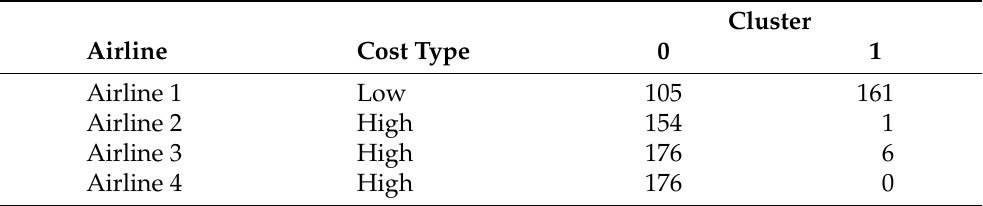
Table 3. Contingency table for Madrid–London Gatwick OD pair, showing the distribution of trajectories across airlines, cost type and clusters.